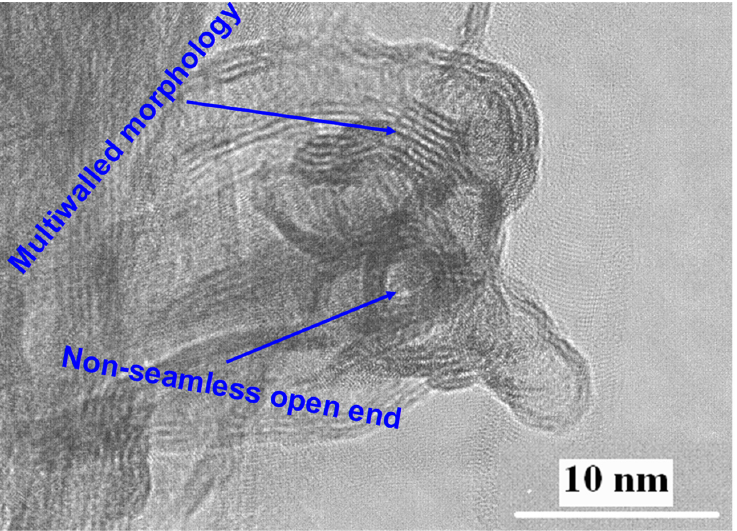
Figure 3. TEM of acid treated nanotubes showing the non-seamless open ends and multiwalled morphology.